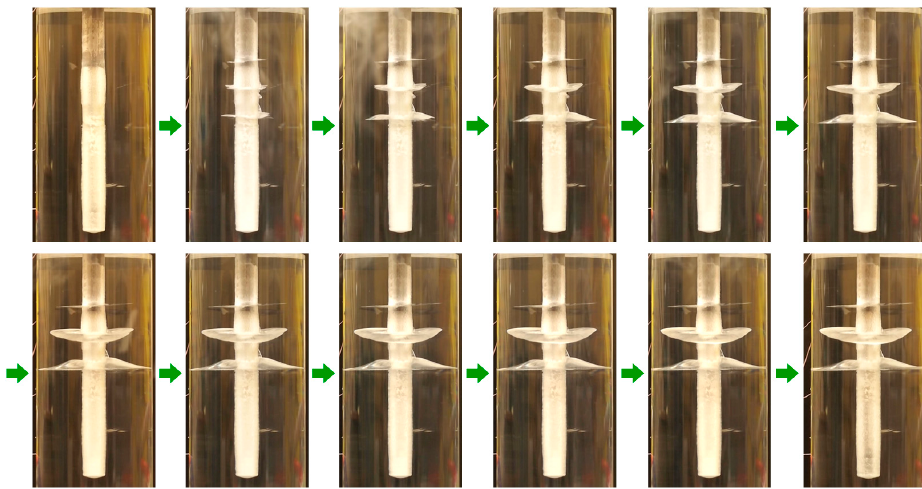
Figure 7. Crack development in Specimen 3.